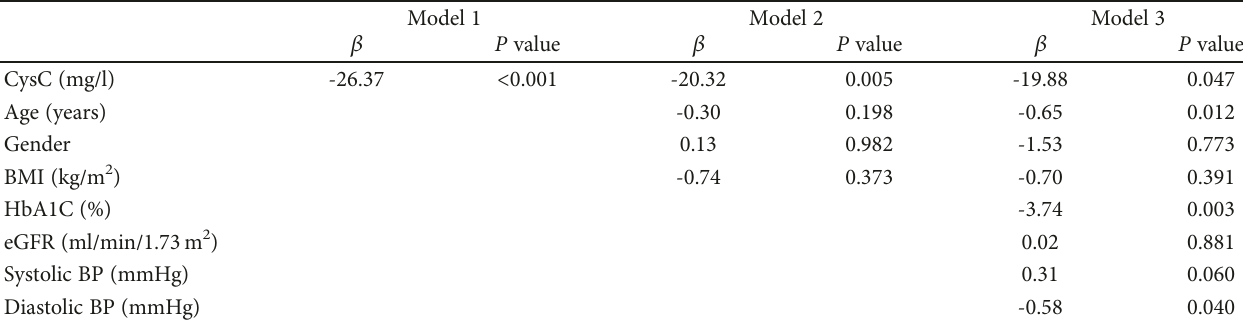
Table 5: Linear regression analysis of SDANN with di ff erent clinical